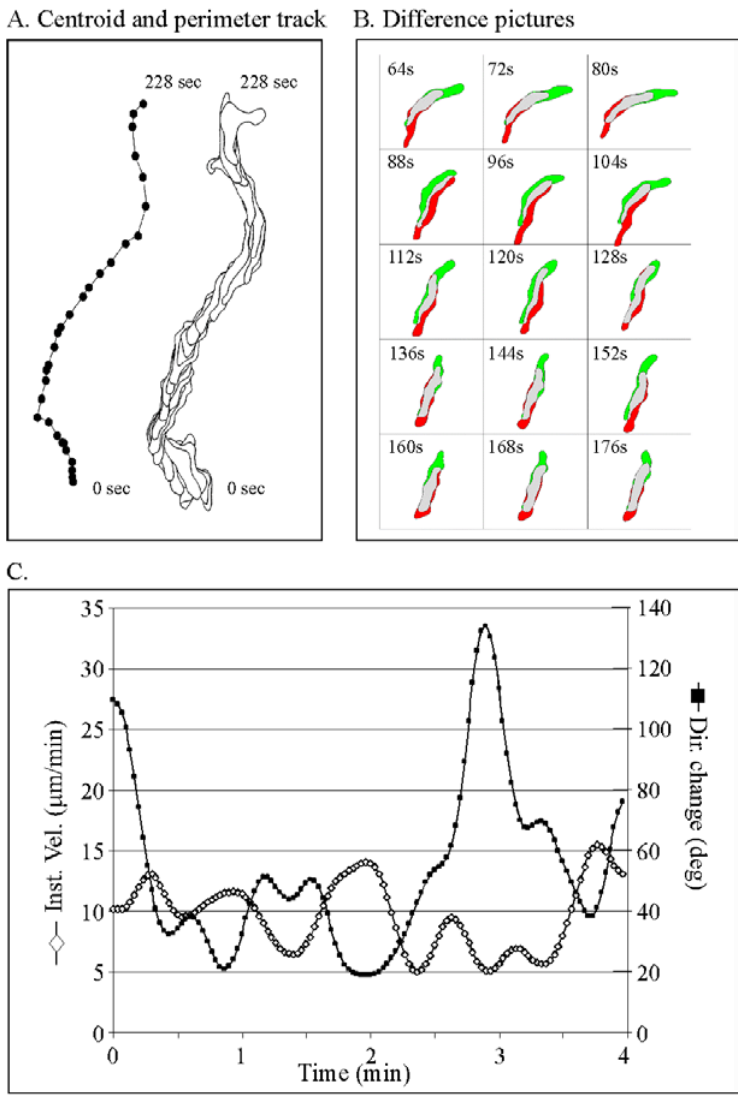
FIGURE 1. 2D-DIAS can generate (A) cell centroid and perimeter tracks, (B) difference pictures in which expansion zones are color- coded green and contraction zones are color-coded red, and (C) quantitative data for over 40 parameters, in this case, instantaneous velocity and directional change (see [10] for details). The cell type analyzed is D. discoideum strain Ax4 in a spatial gradient of